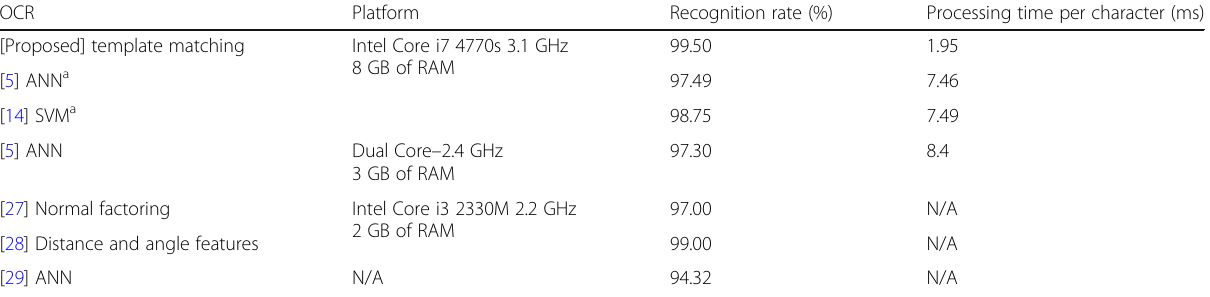
a The algorithm has been implemented and tested by the authors using the training and testing sets of this work to process numeral characters